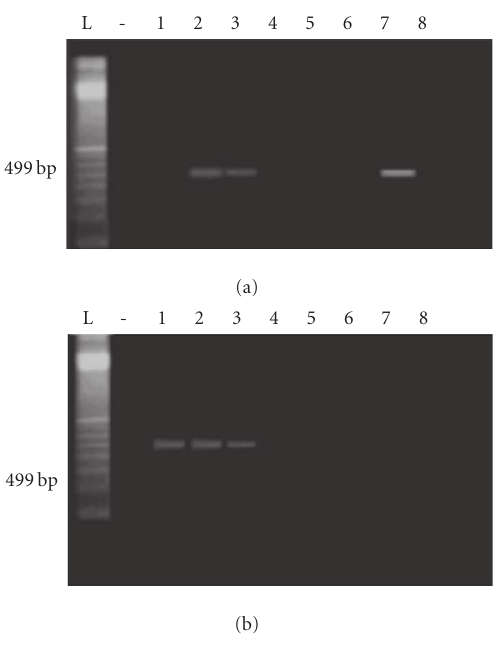
Figure 2. Enterotoxin A gene amplification: lanes L and (-): 100- bp ladder and negative control. (a) Lanes 2–8: S aureus ampli- cons from psoriatic patients. (b) Lanes 1–3: S aureus amplicons from psoriatic patients. Lanes 4 and 5: S aureus amplicons from